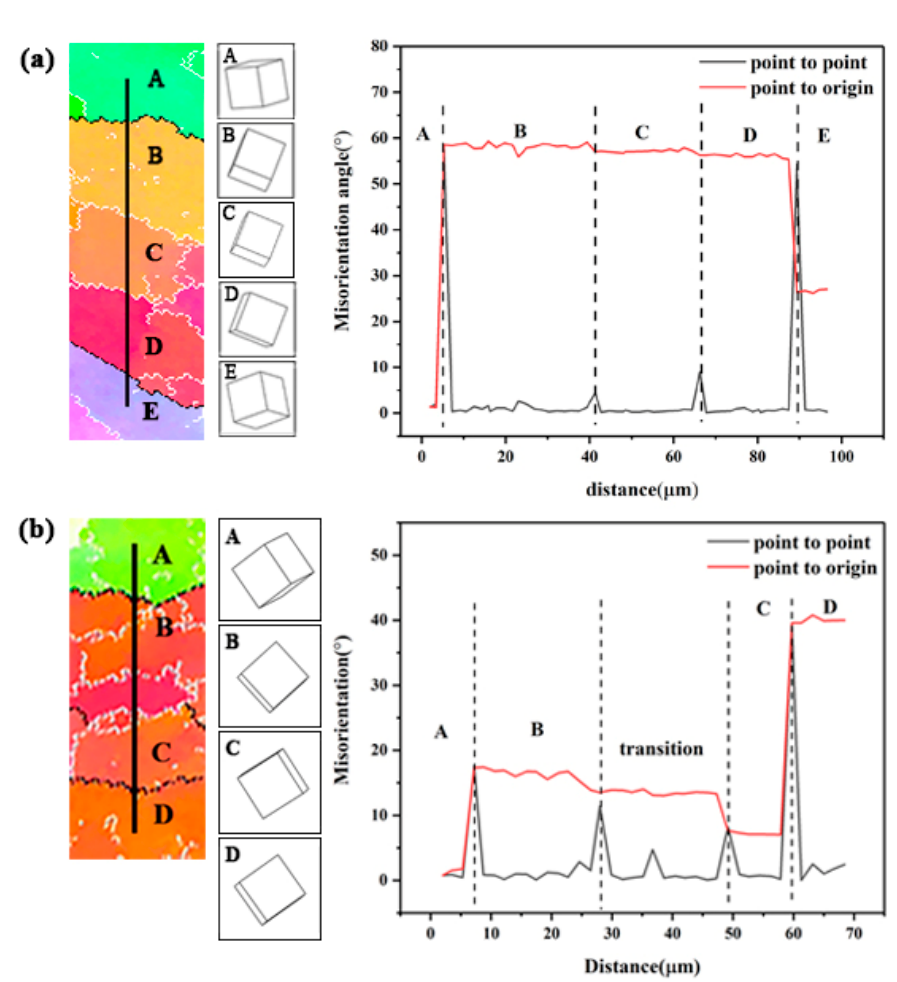
Figure 10. Orientation change along ( a ) line 1 and ( b ) line 2.